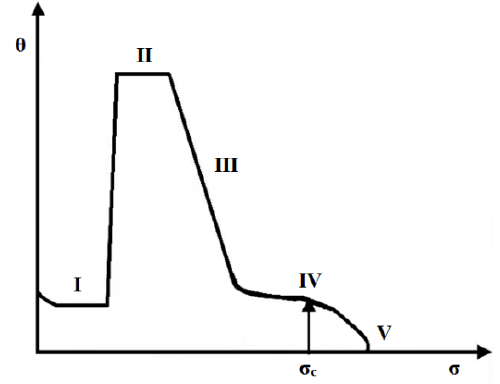
Figure 2. Sketch map of strain hardening rate θ and stress σ.